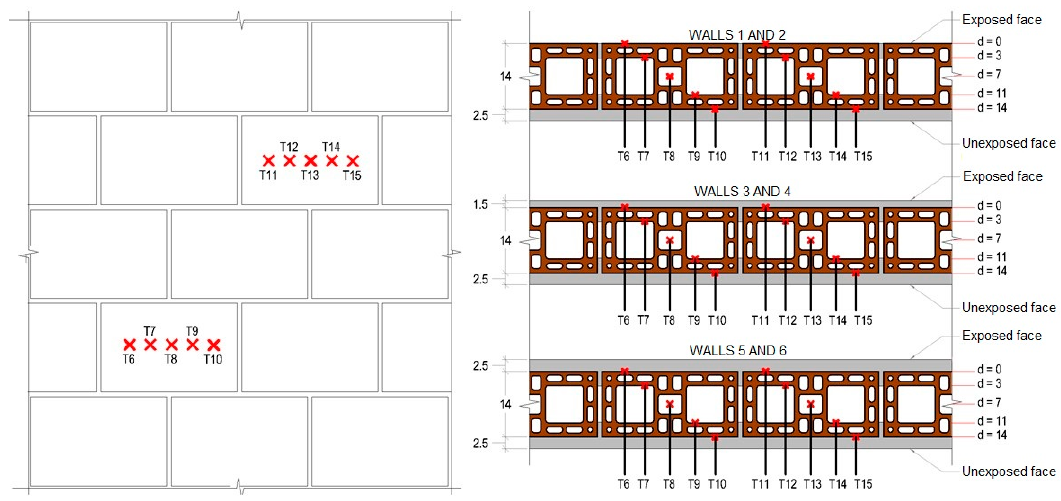
Figure 3. Thermocouple placement along the thickness of the wall.